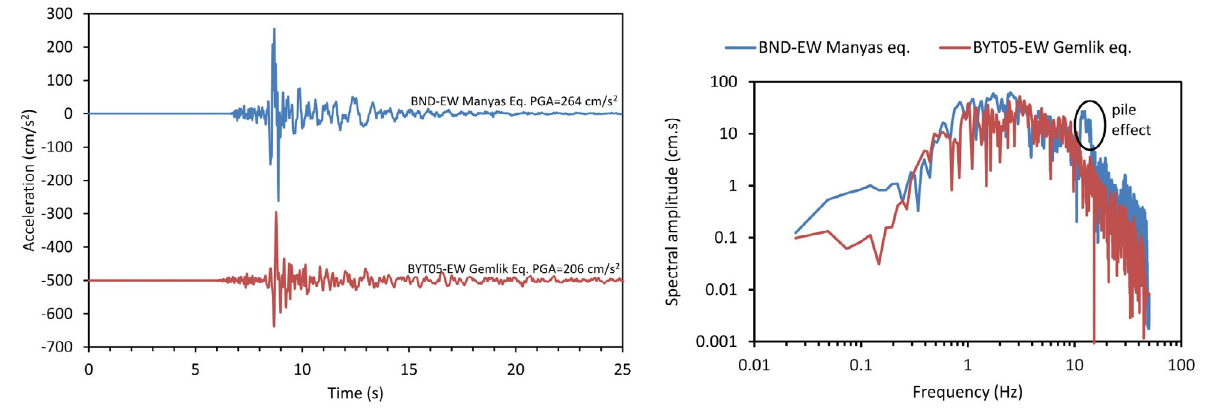
Figure 2. EW component waveforms (left) and spectra (right) of the Manyas (blue line) and Gemlik (red line) earthquakes recorded at BND and BYT05 stations, respectively, are compared. The amplification around 12 Hz caused by instrument pile effect was pointed on the spec- trum of BND